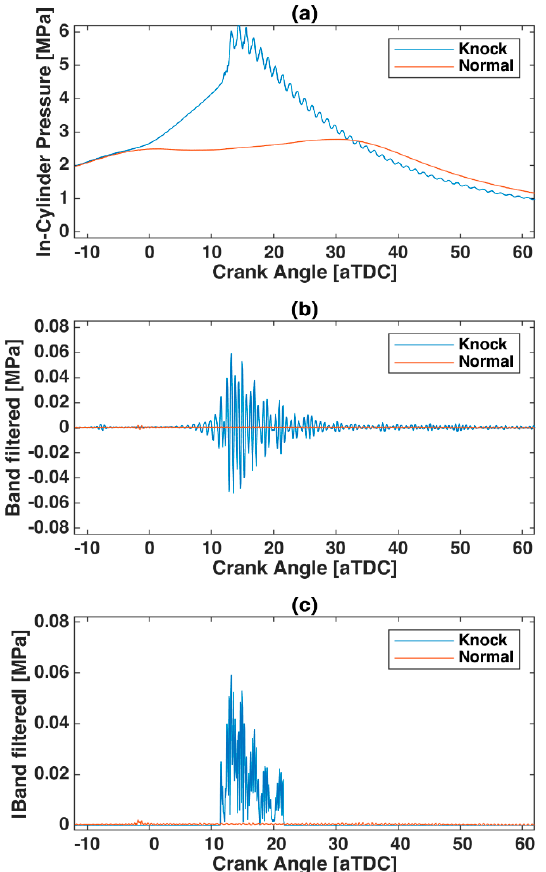
Figure 3. ( a ) In-cylinder pressure trace, ( b ) band filtered signal, and ( c ) modulus of band filtered knock-cycle and normal-cycle signals.